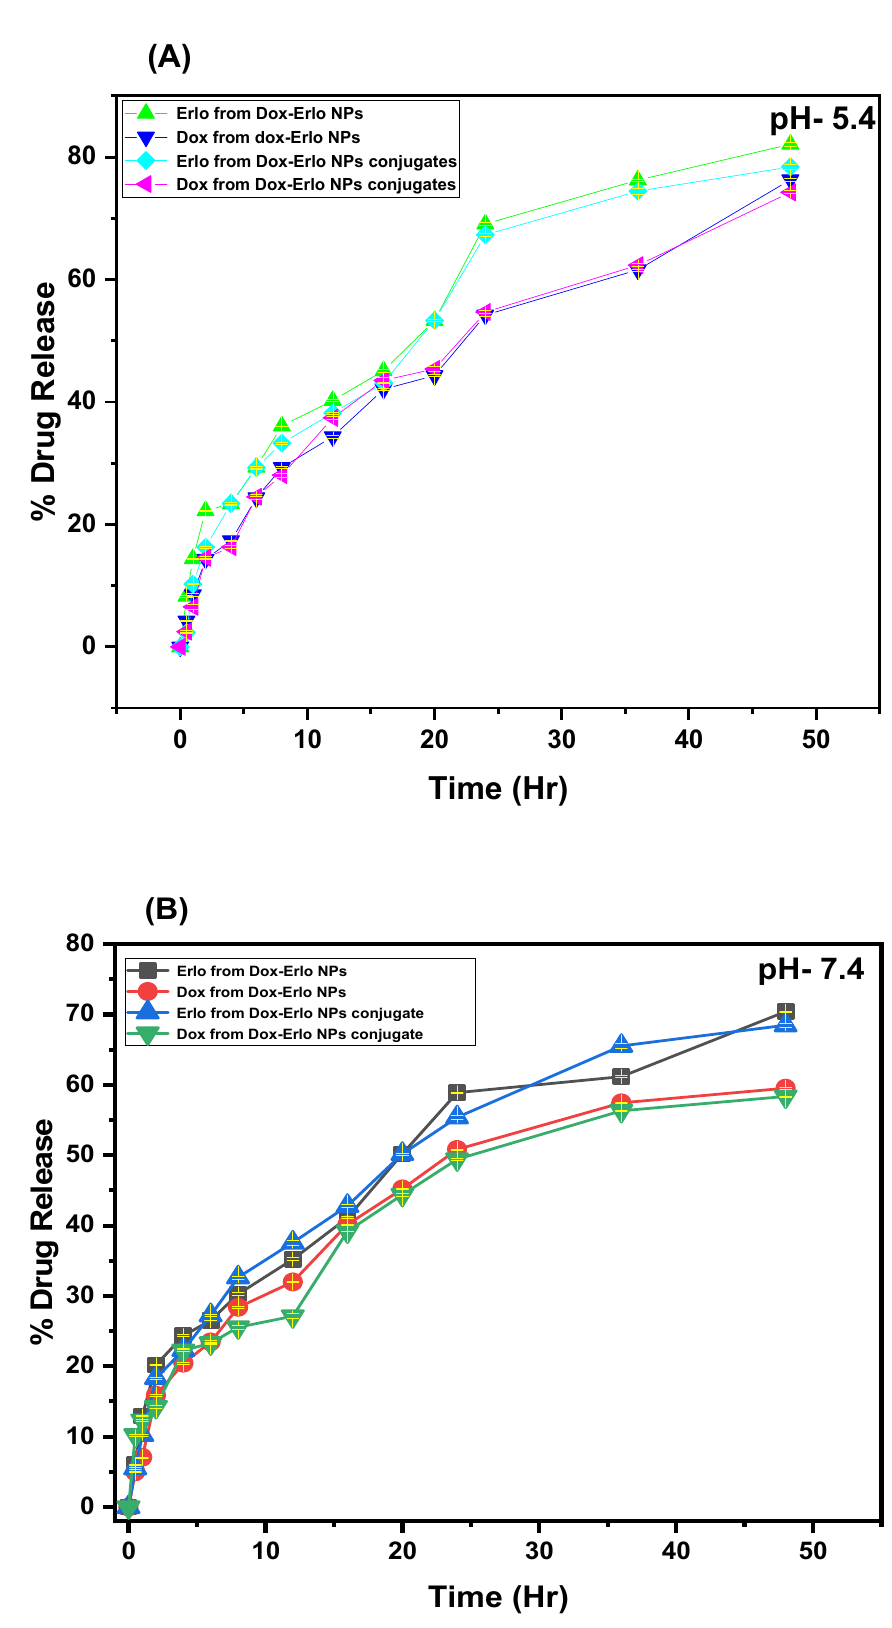
Figure 9. In vitro drug releases of Erlo and Dox from the plain drug, Dox–Erlo NPs, and Dox–Erlo-NP conjugates at a pH of 5.4 ( A ) and a pH of 7.4 ( B ).